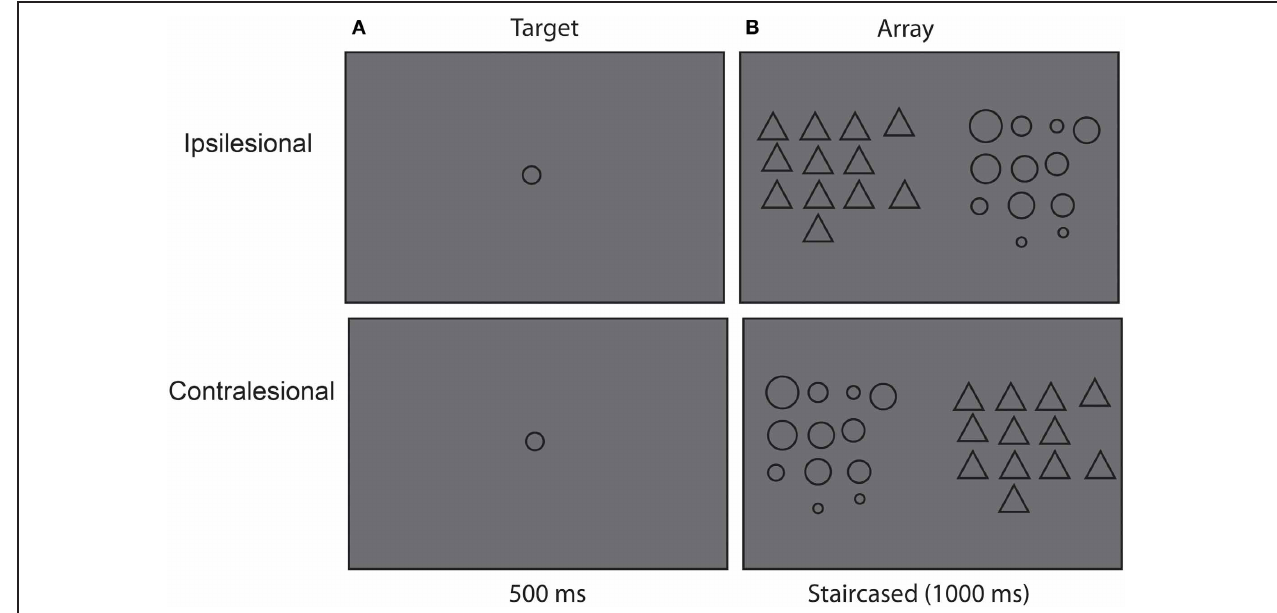
FIGURE 2 | Experimental procedure. (A) First patients viewed a target circle and were asked to remember its size. (B) Next, patients viewed a display of 12 circles and distractor triangles. The position of the circles and